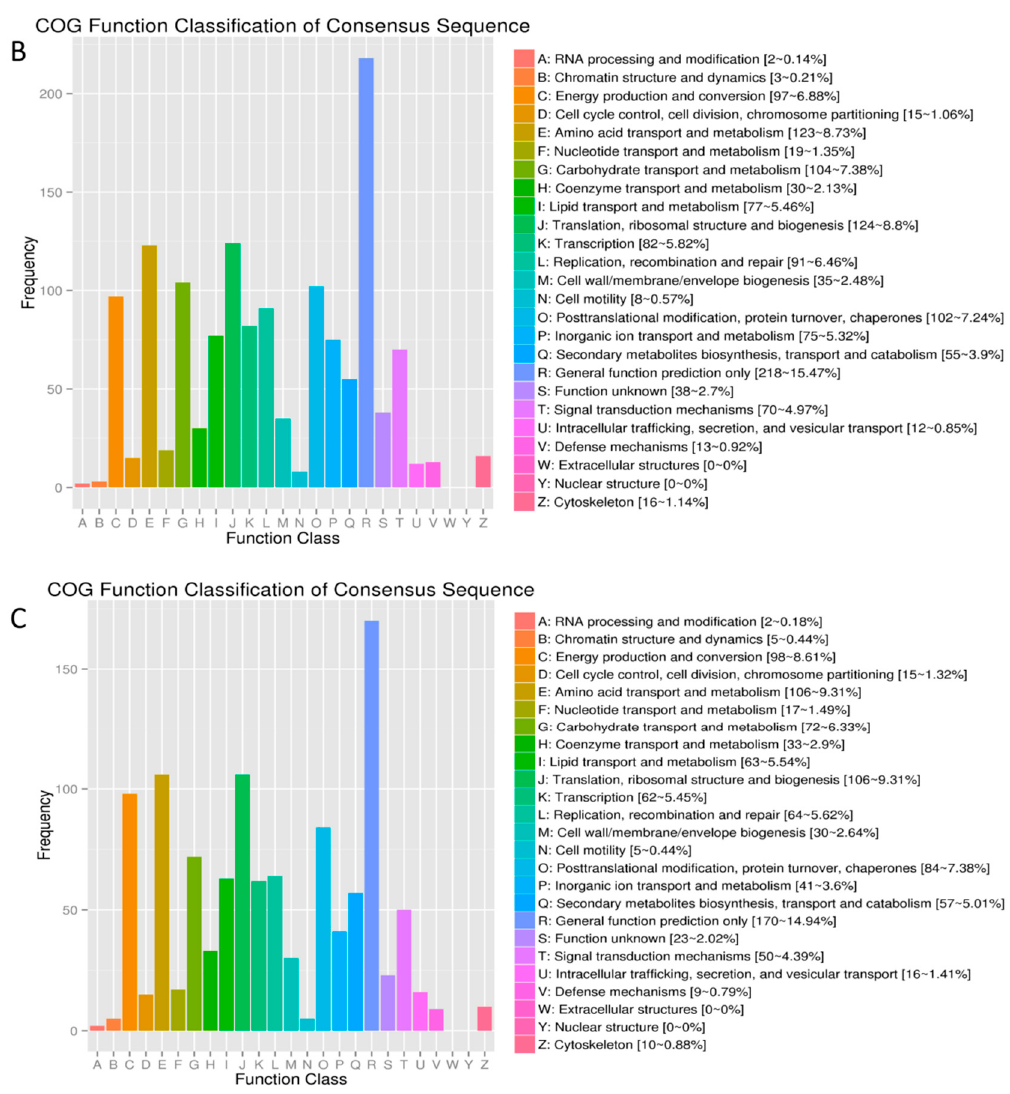
Figure 3. Clusters of orthologous groups (COG) classification of B. dorsalis and B. correcta unigenes. The abscissa is the COG content of 25 function categories, while the ordinate is the number of genes. The COG classification of DEGs for larvae, females and males was indicated by ( A ), ( B ), and ( C ), respectively.